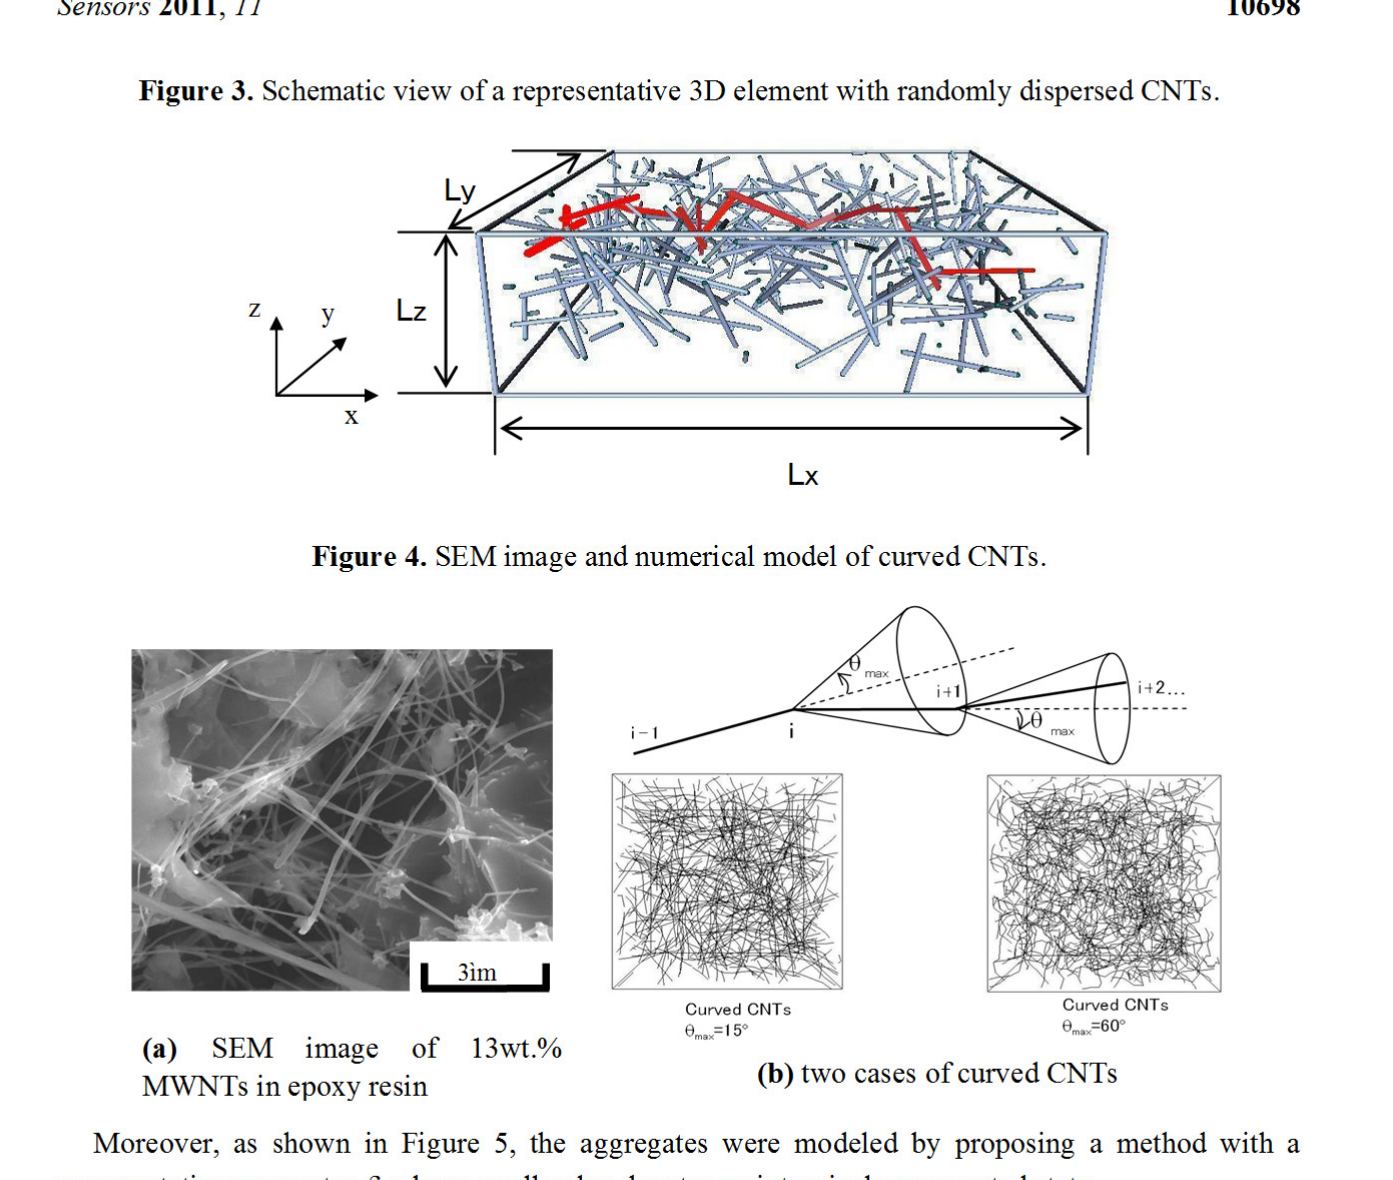
Figure 3. Schematic view of a representative 3D element with randomly dispersed CNTs.